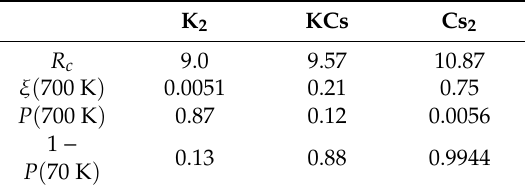
Table 1. The first row gives the crossing points R c of the potential curves of electronic states A and b for K 2 , KCs, and Cs 2 molecules. In the second row, the Massey parameters at the crossing points for the temperature T = 700 K are given. In the third and fourth rows, the averaged probabilities P of atoms moving in diabatic potentials and the probabilities for atoms moving in adiabatic electronic potentials are given, respectively. K 2 KCs Cs 2 R c